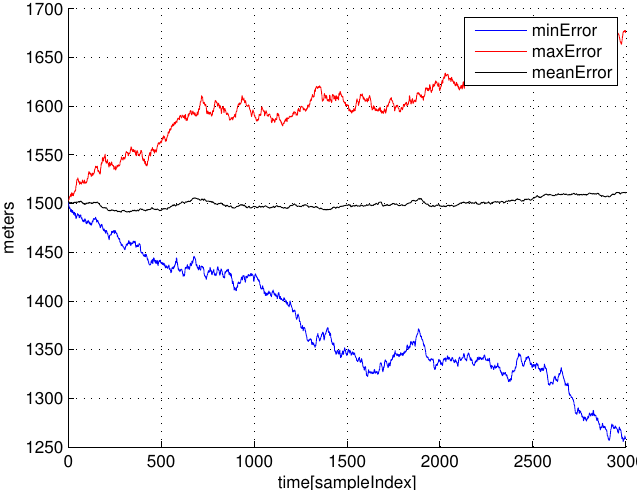
Figure 6. Consider the case where the Inertial Measurement Units (IMU)-only localization is used. We plot meanE k , maxE k , and minE k with respect to sample-index k . Since no ship is used to fix long-term drift, the estimation error does not decrease as time goes on. Compared to Figures 2 and 4, the estimation error